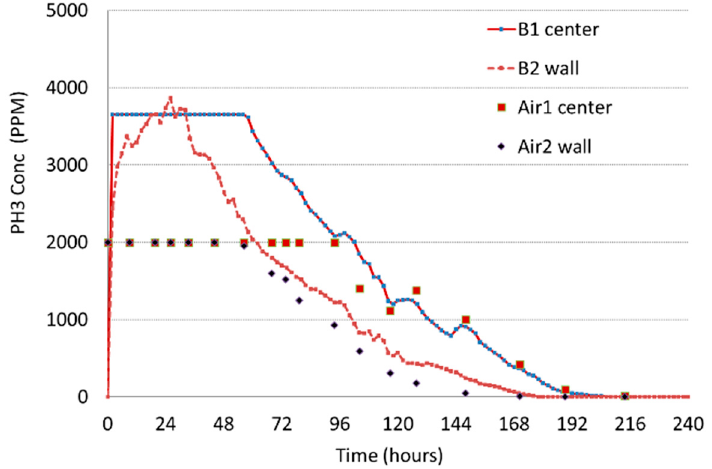
Figure 5. Fumigation Trial #1: 320 Phostoxin tablets were probed into the top of grain and had no supplemental airflow. B1 and B2 are the wireless sensors in bin B while Air1 and Air2 are the airlines positioned next to the sensors.